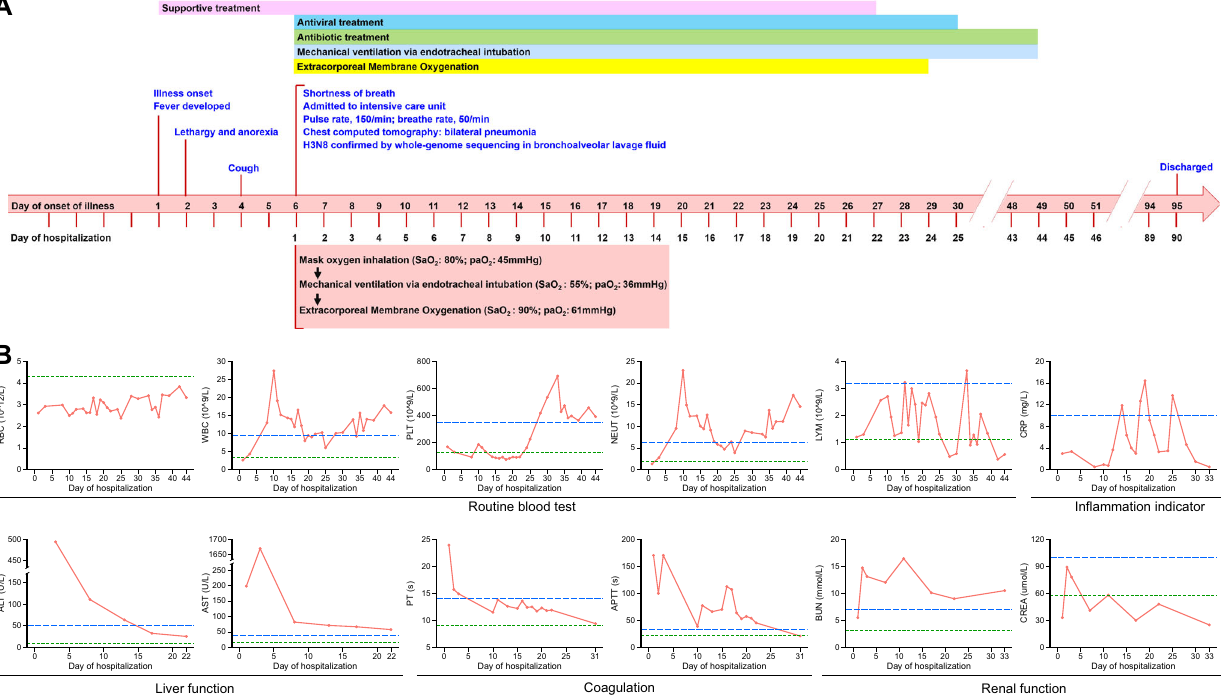
Fig. 1 | Timeline of theclinicalcourse ofthe patient, identi fi cation ofcausative pathogen and dynamic changes of laboratory indicators during hospitaliza- tion. A Timeline of the clinical course of the patient. B Dynamic changes of laboratory indicators during hospitalization. The blue dotted line represents the upper limit of the normal range, and the green dotted line represents the lower